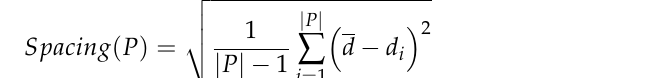
Figure 5. Ten optimization results of MOBA and MOBA/G.